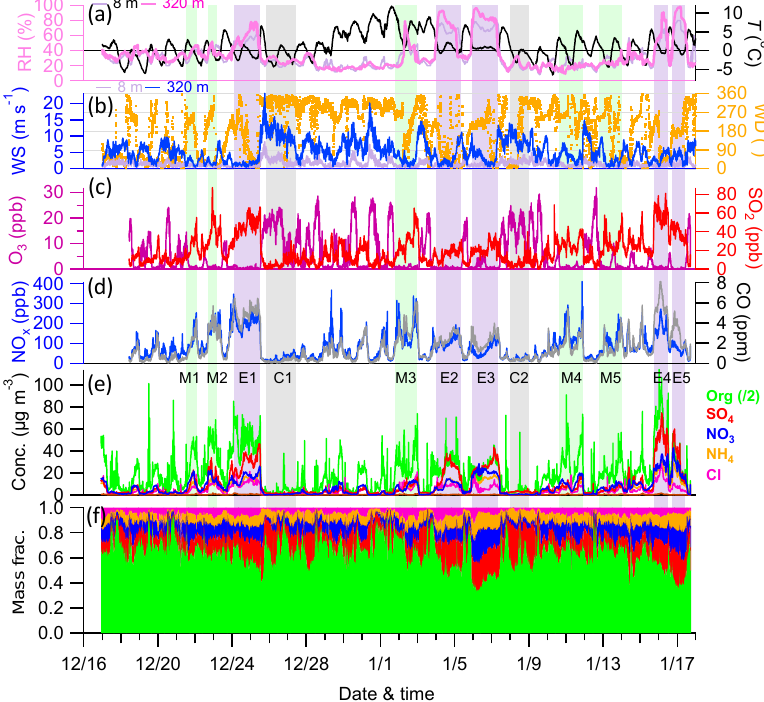
Figure 1. Time series of (a) relative humidity (RH) and temperature ( T ), (b) wind speed (WS) and wind direction (WD), (c) O 3 and SO 2 , (d) CO and NO x , (e) mass concentrations of NR-PM 1 species and (f) mass fractions of NR-PM 1 species for the entire study period. In addition, five episodes with relatively high RH levels (E1–E5), five episodes with moderately high RH levels (M1–M5), and two clean periods (C1, C2) are marked for further discussion.